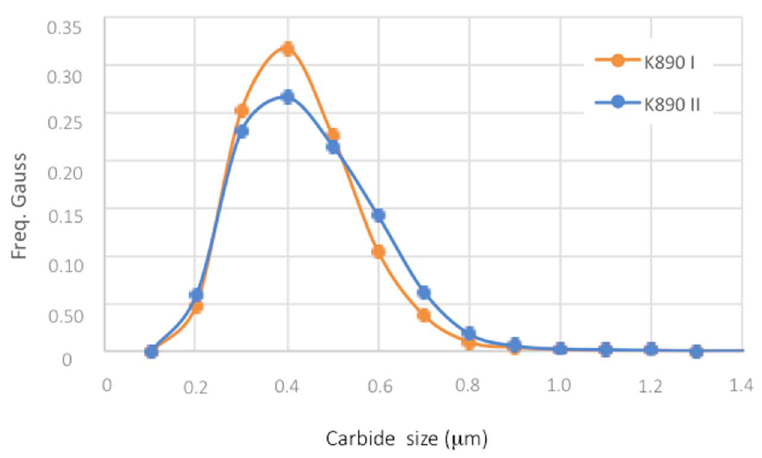
Figure 6. Gaussian distribution of carbides size in K890-I and K890-II specimens. K890-II presents smaller carbides size (peak value) and a more homogeneous (amplitude) carbide distribution.